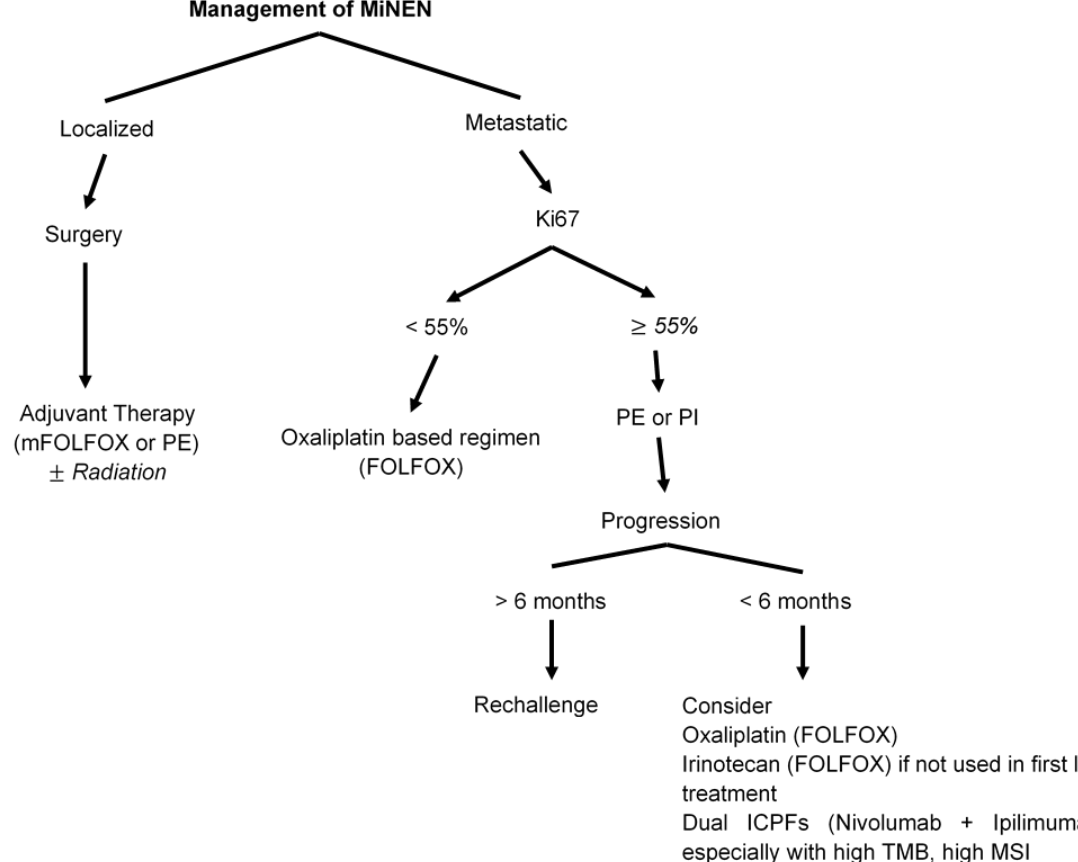
Figure 5. Management of mixed neuroendocrine-non-neuroendocrine neoplasms (MiNENs).